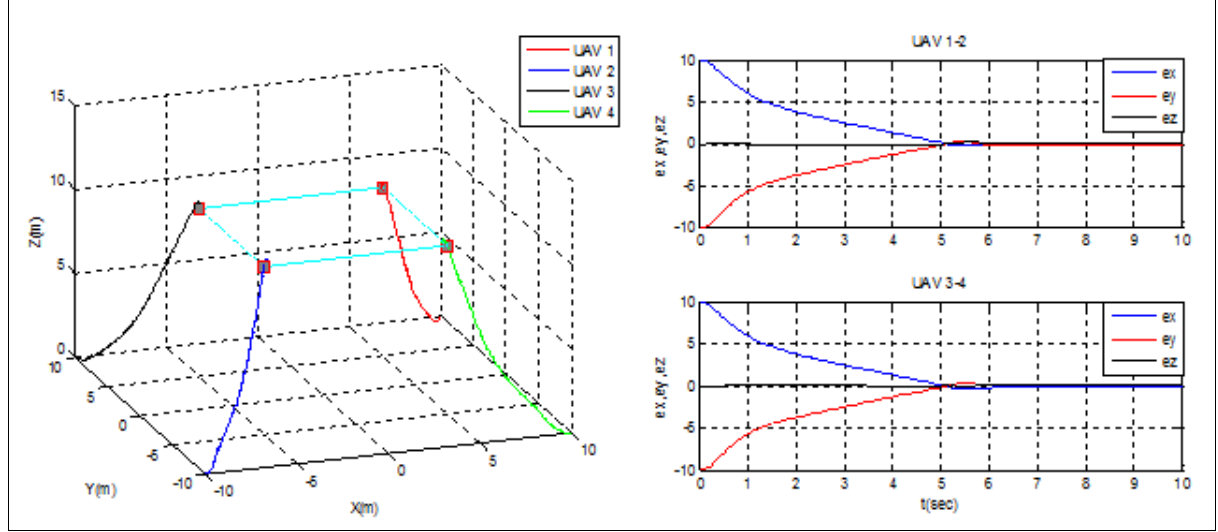
Figure 6. Relayed MEC under distributed